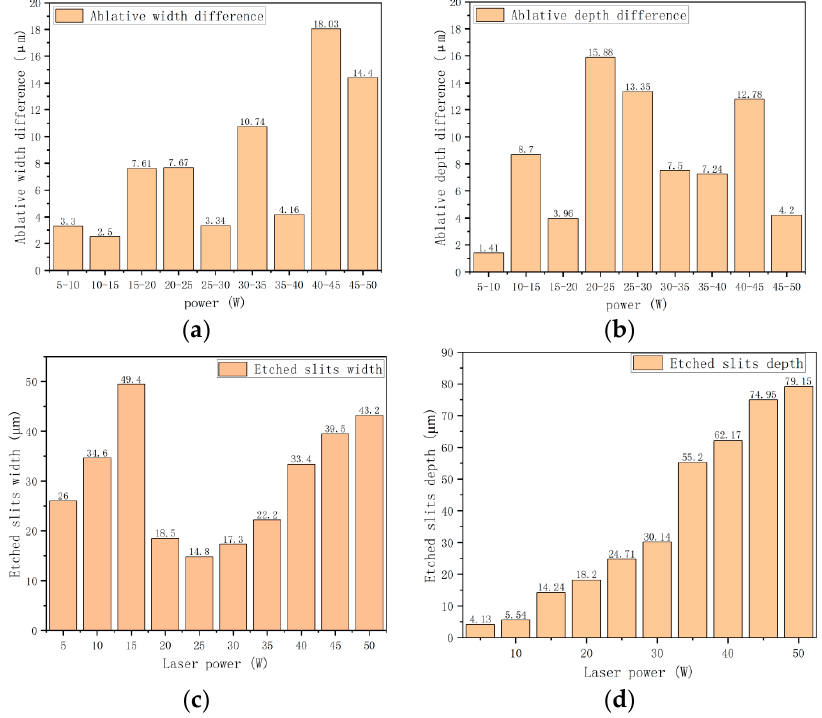
Figure 5. ( a ) Difference in the ablation depth; ( b ) difference in the ablation width; ( c ) ablation width trend diagram; ( d ) ablation depth trend diagram.